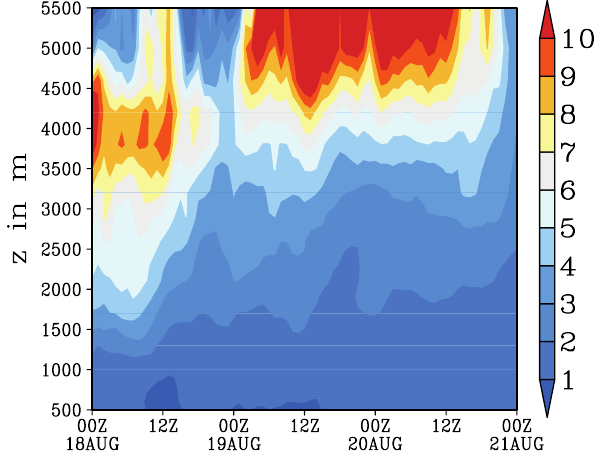
Fig. 7. Time evolution of the profile of the ratio of horizontally averaged CCN (0.1%) concentrations at grid cells containing cloud water and at cloud free grid